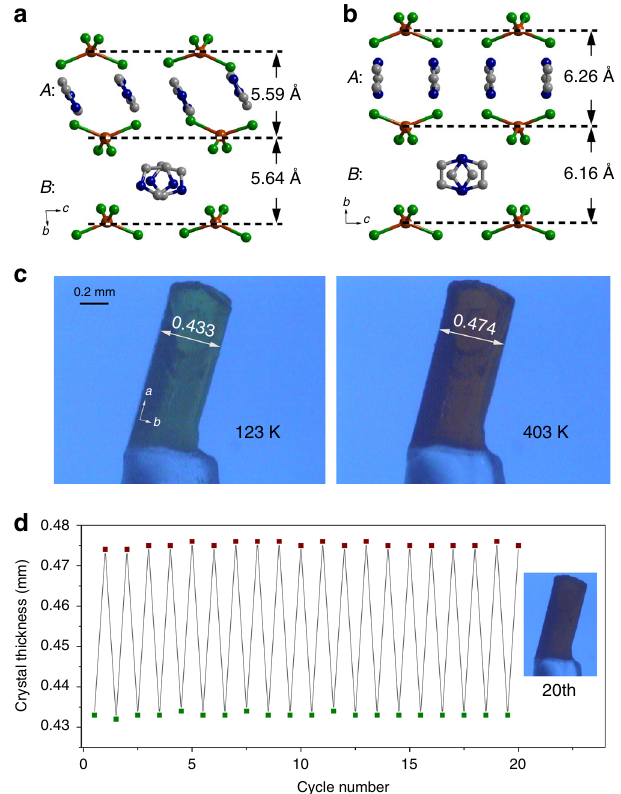
Fig. 3 The variation of interlayer distance and corresponding crystal deformation. a The interlayer distance at 123 K. b The interlayer distance at 393 K. Upon heating from 123 to 393 K, the interlayer distance between CuCl 4 2 − dianions separated by the Himd + cations in layer A increases from 5.59 to 6.26 Å, while that separated by layer B increases from 5.64 to 6.16 Å. c Photographs of the crystal deformation recorded at 123 K (left) and 403 K (right) upon heating. (The length of scale bar is 0.2 mm.) The thickness of the crystal corresponds to the crystallographic b -axis. d Durability test of the crystal transformation. The inset shows a photograph of the crystal after 20 cycles. The expansion and shrinkage of the crystal thickness were recorded over 20 cycles without signi fi